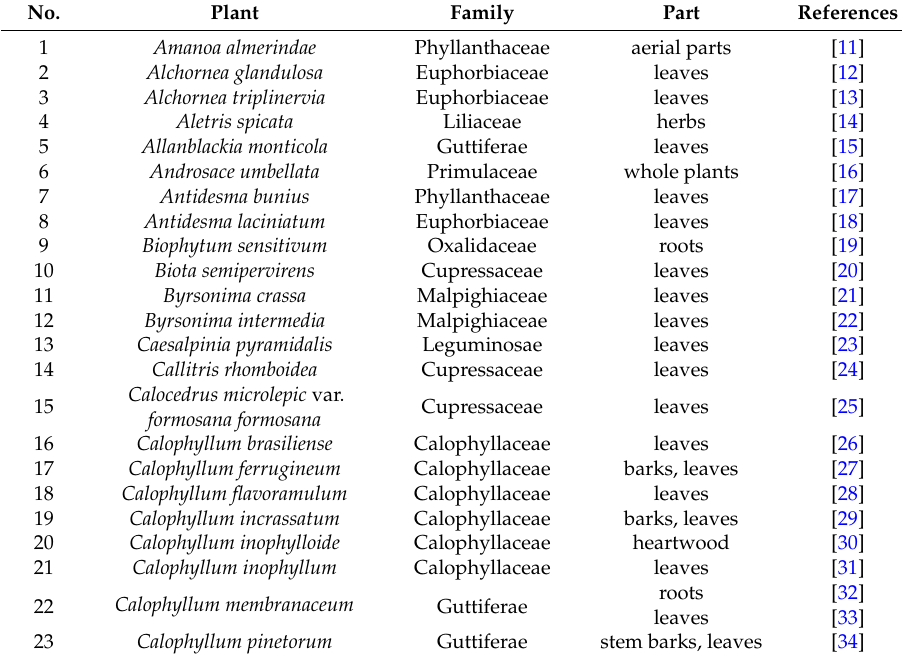
Table 1. Plants containing amentoflavone.